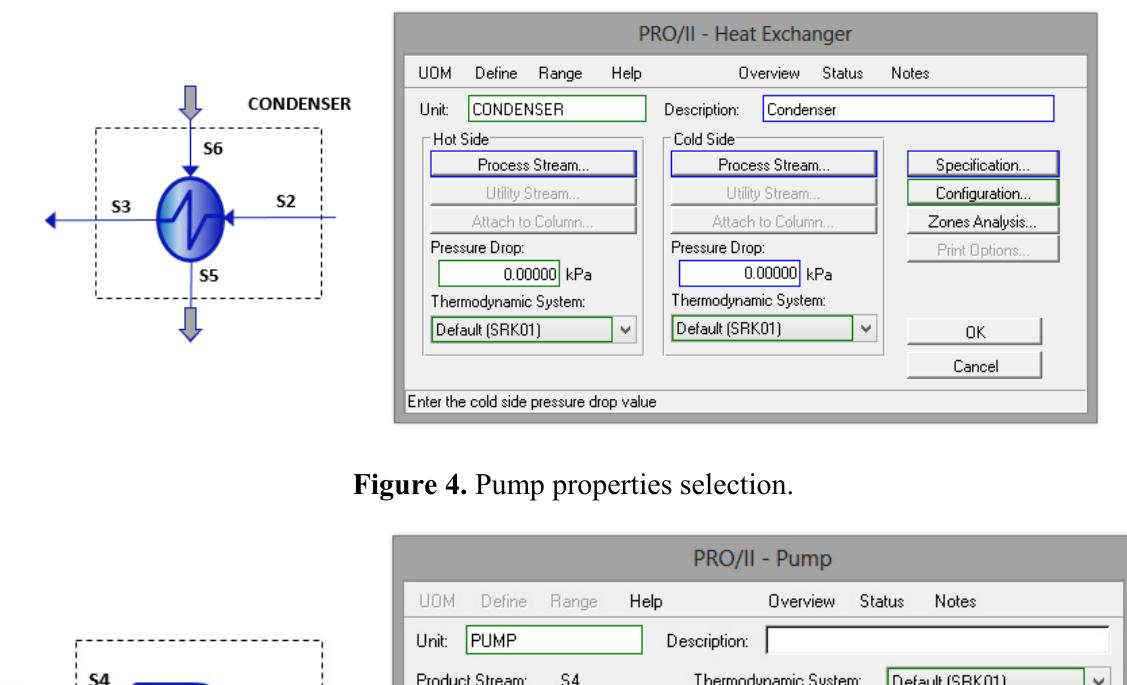
Figure 3. Condenser properties selection.